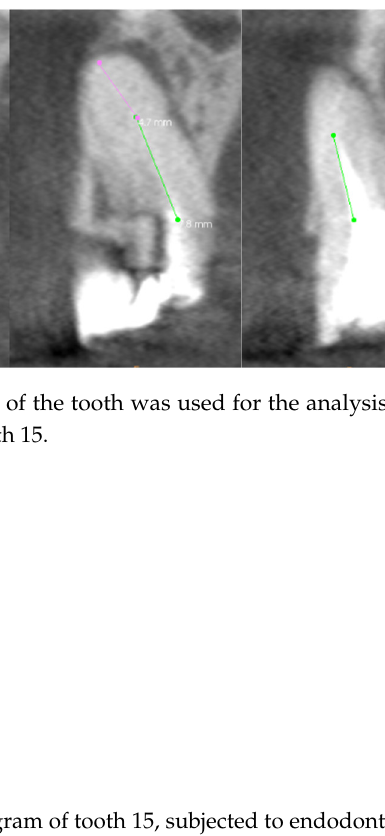
Figure 12. The 3D hologram of tooth 15, subjected to endodontic treatment. Table 4. The minimum number of scans for each root canal is needed to analyze its entire course and the percentage of the length of the canal visible on the scan, in the case of the treatment of tooth 15. The Number of Shots Needed to Type of Root Canal Visualize/Evaluate the Entire Root Canal